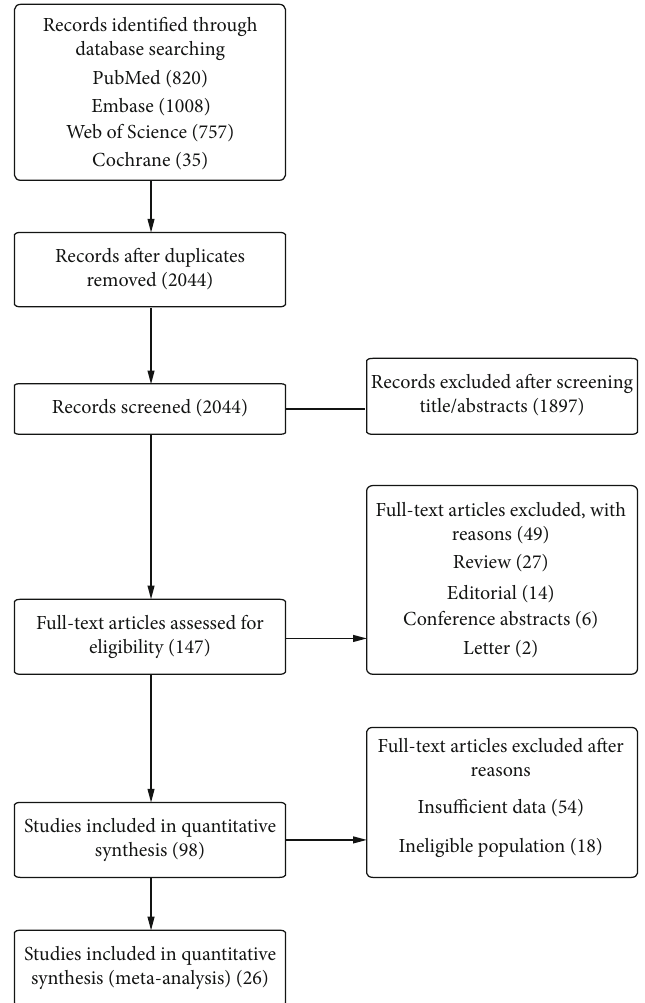
Figure 1: Flow diagram of systematic literature